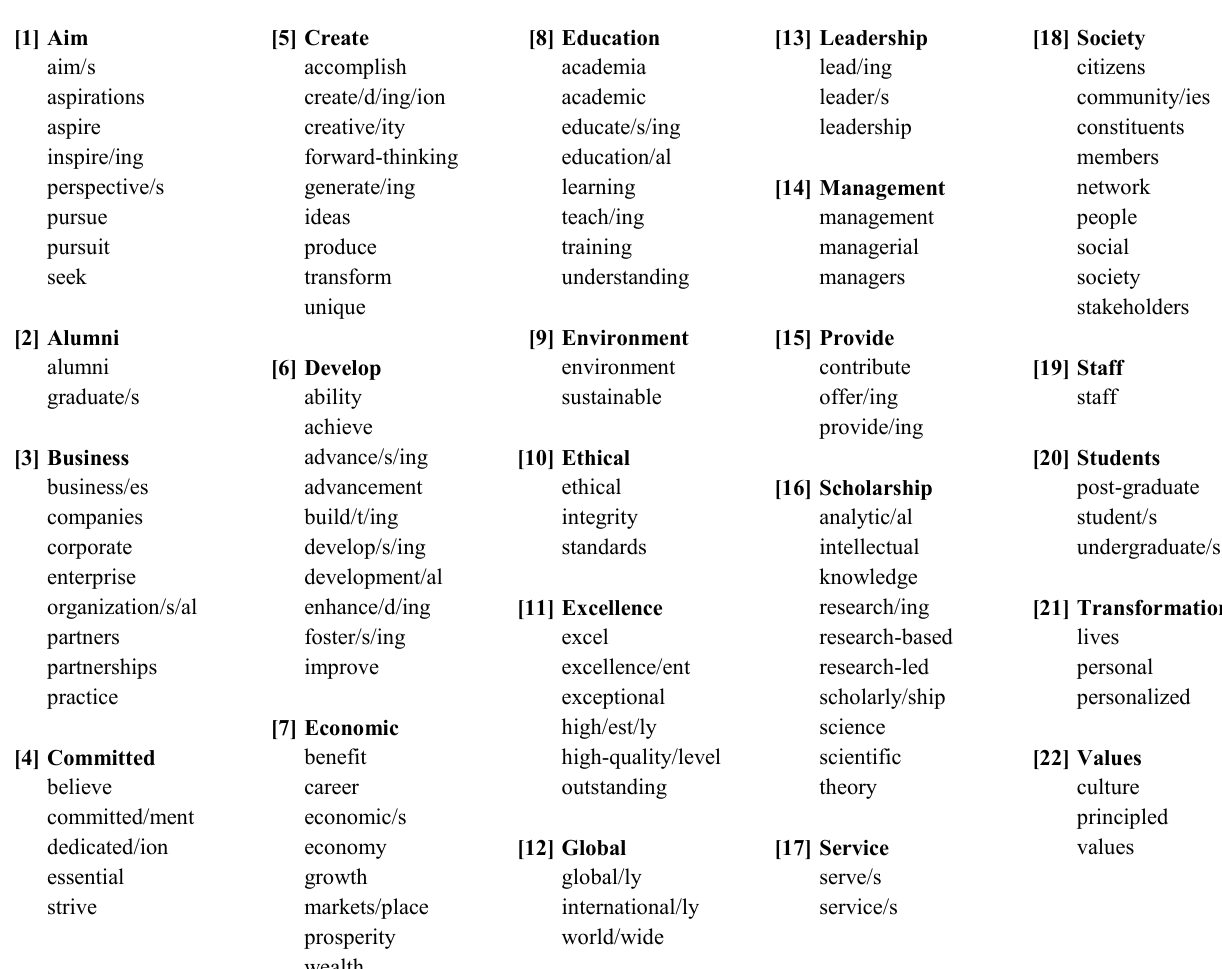
Figure 3 graphs how many of the 100 mission statements include the twenty-two aggregated concepts as well as the residual concept words that did not form part of the concept maps. The figure clearly demonstrates the broad distribution with most occurring in considerably less than ten percent